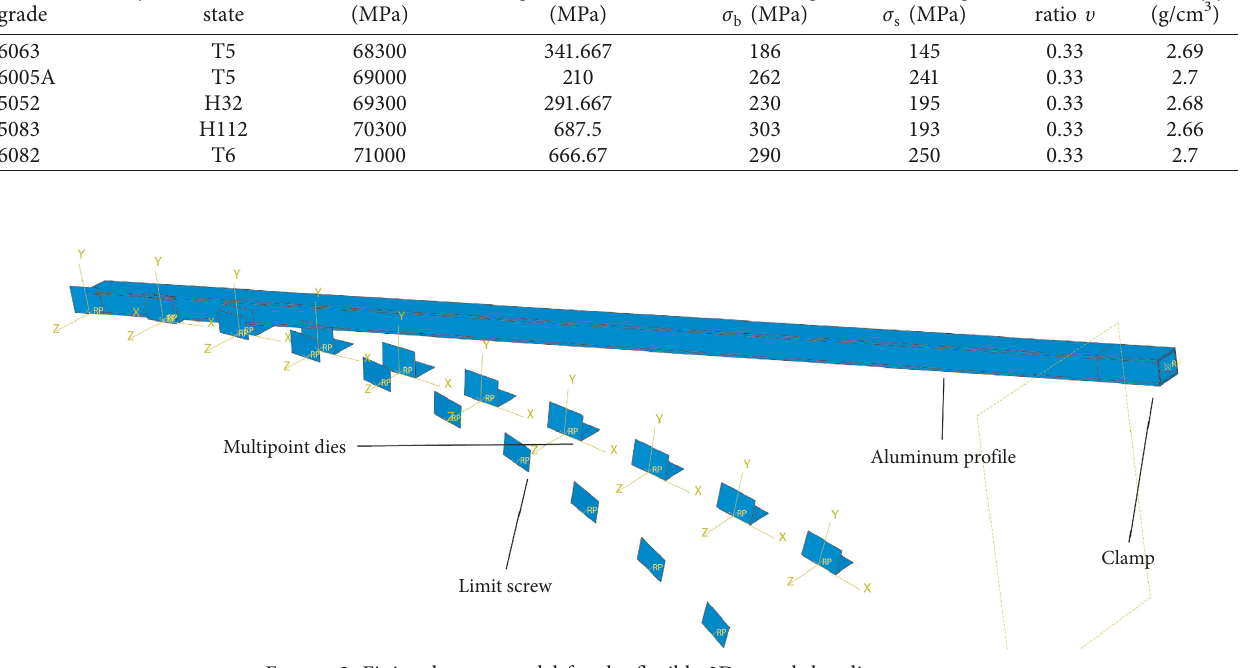
Figure 2: Finite element model for the flexible 3D stretch-bending